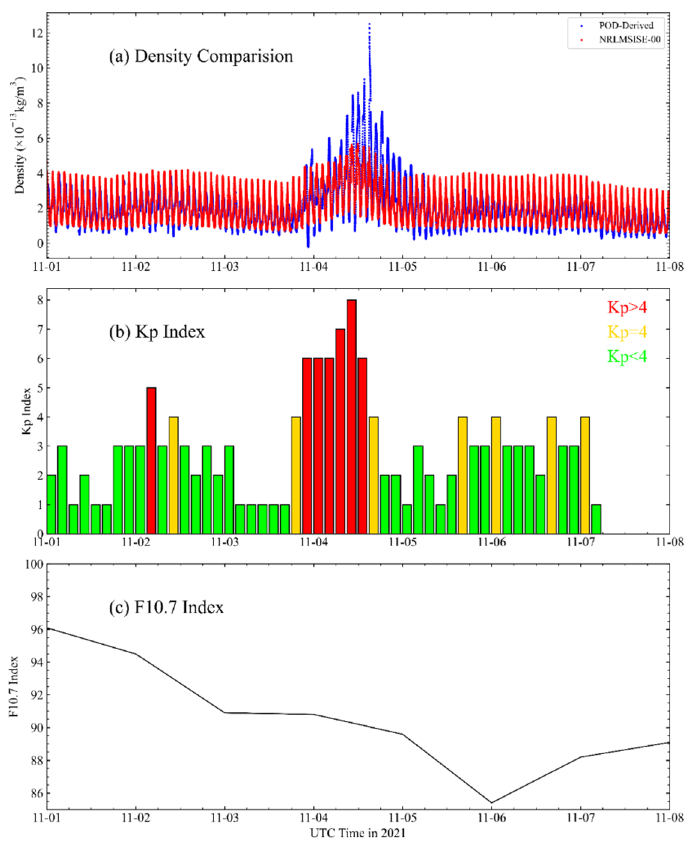
Figure 9. ( a ) A temporal comparison between the POD-derived densities and the NRLMSISE-00 atmospheric density model results; ( b ) Kp index; and ( c ) F10.7 index. The first epoch is noted at 21 h on 1 November 2021 (UTC).